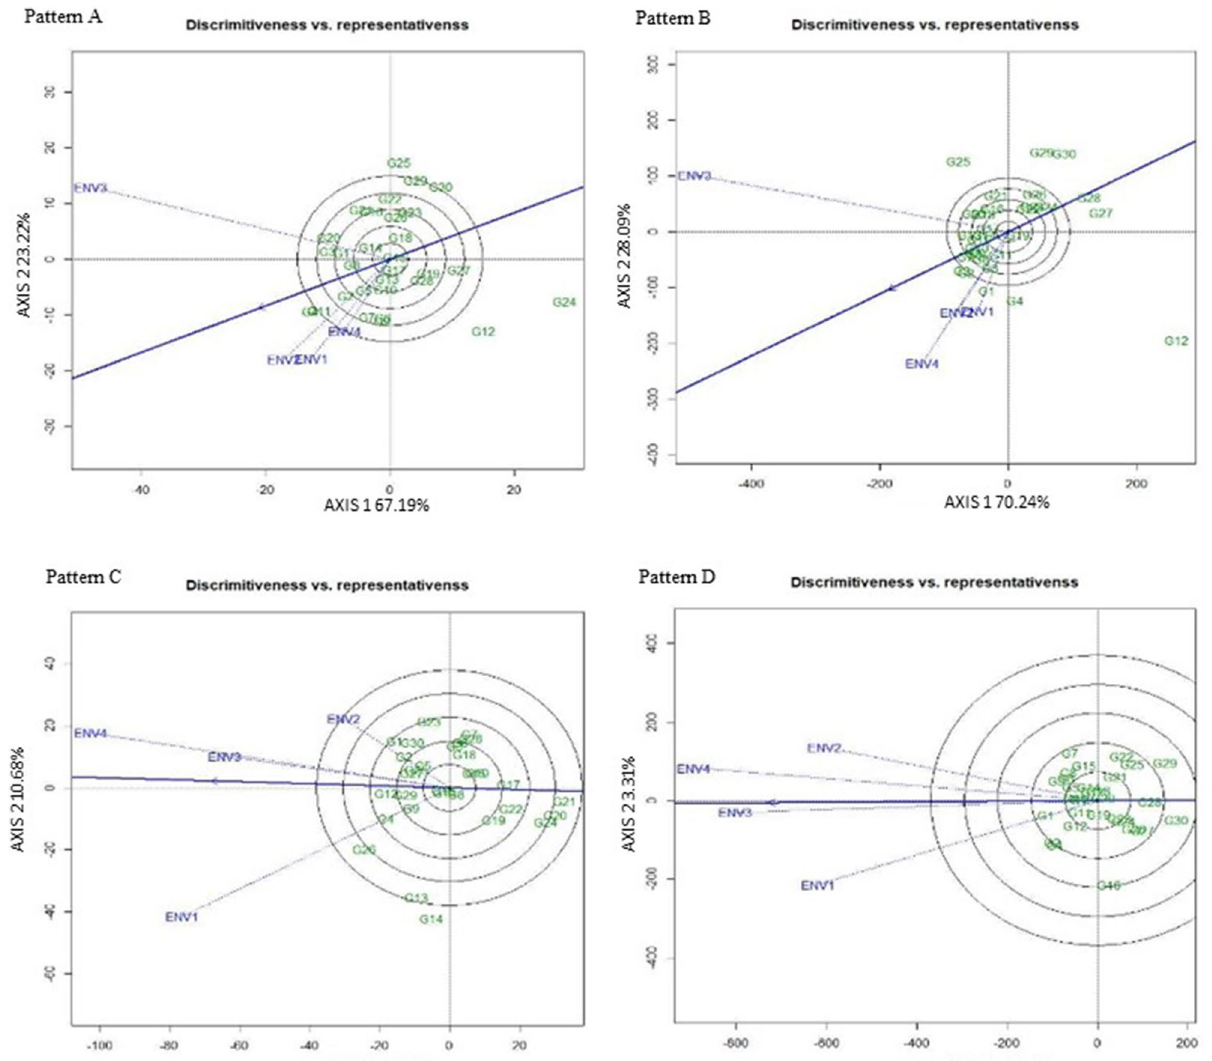
Figure 4. The GGE biplot ‘Descriminitiveness vs. Representativeness’ pattern for genotype comparison with ideal genotype showing G + G × E interaction effect of 30 V . subterranea genotypes under two season two location for total number of pods (Pattern A), fresh pod weight (Pattern B), hundred seed weight (Pattern C), yield per hectare (Pattern D). The biplots were created based on Centering = 0, SVP = 2, Scaling =